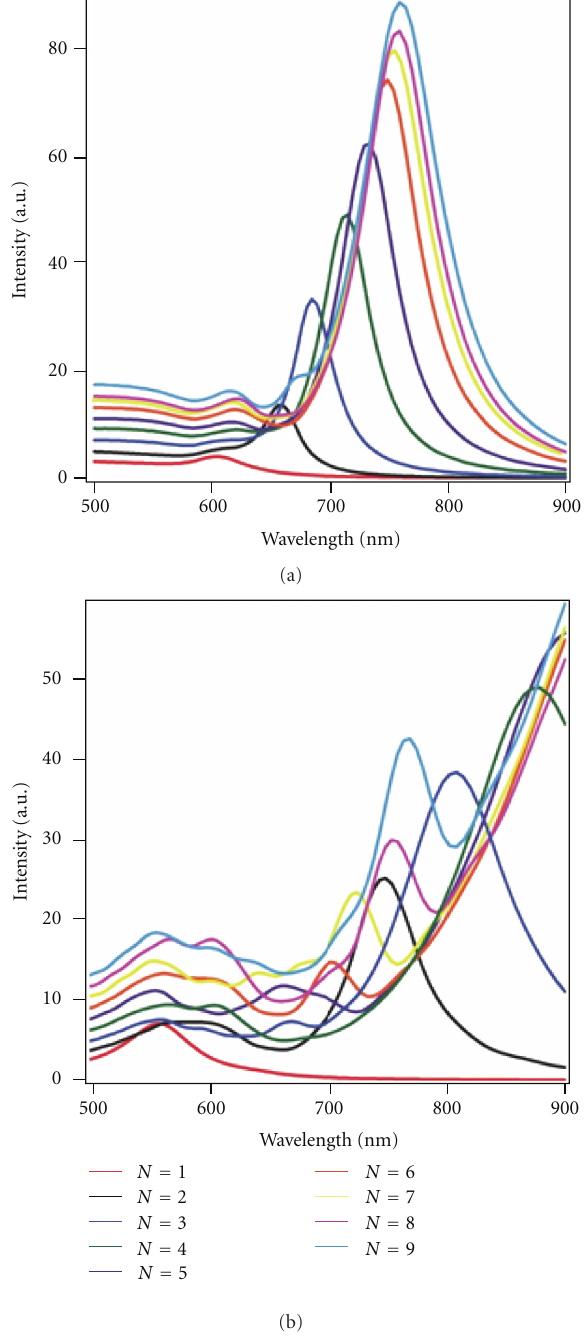
Figure 2: FDTD calculations of the extinction spectra for 60 nm Au nanoparticle chains 1–9 nanoparticles in length. Nanochains in (a) have a 1 nm interparticle separation and are embedded in a medium with refractive index n e ff = 1 . 0. Nanochains in (b) have a 1.5 nm interparticle separation and are embedded in a medium with refractive index n e ff = 1 .